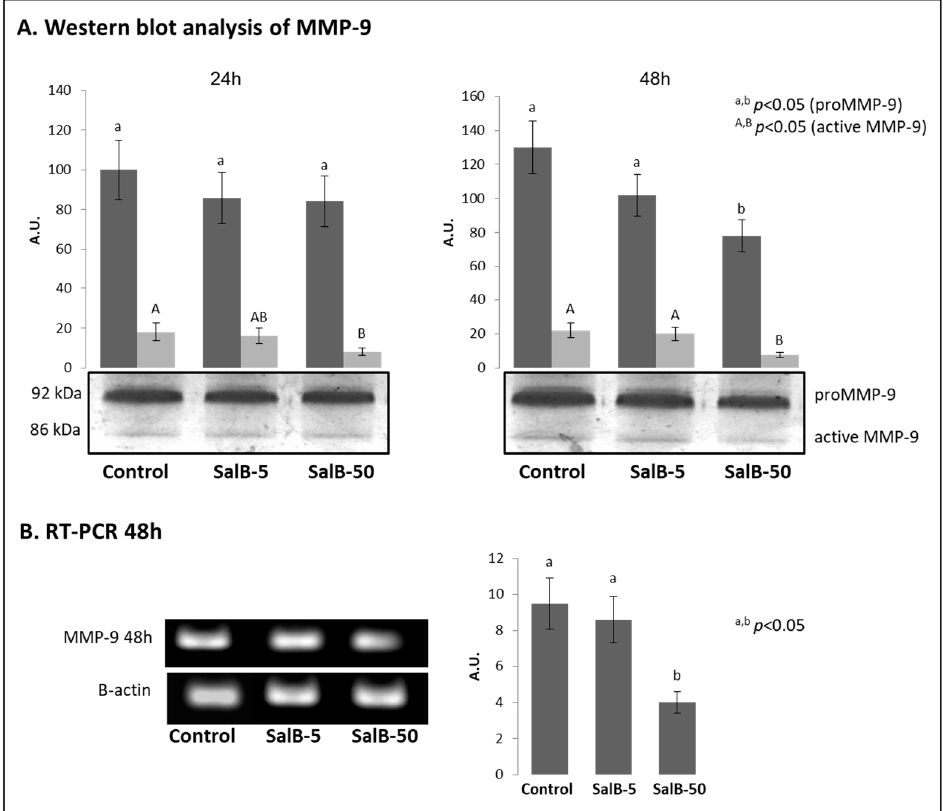
Figure 6. Analysis of TIMP-1 through reverse zymography, Western blot and RT-PCR. The Western blot analysis and RT-PCR of MMP-9. ( A ) The MMP-9 expression was firstly evaluated through Western blot on conditioned media obtained from MDA-MB-231 cells treated for 24 h and 48 h with SalB 5 and 50 µM. Different lower case letters (a,b) indicate significant differences ( p < 0.05) for the proMMP-9, while different upper case letters indicate significant differences ( p < 0.05) for the active form of MMP-9. ( B ) The collection of MDA-MB-231 cells was useful to perform the analysis on MMP-9 transcripts after 48 h treatment with SalB 5 and 50 µM.